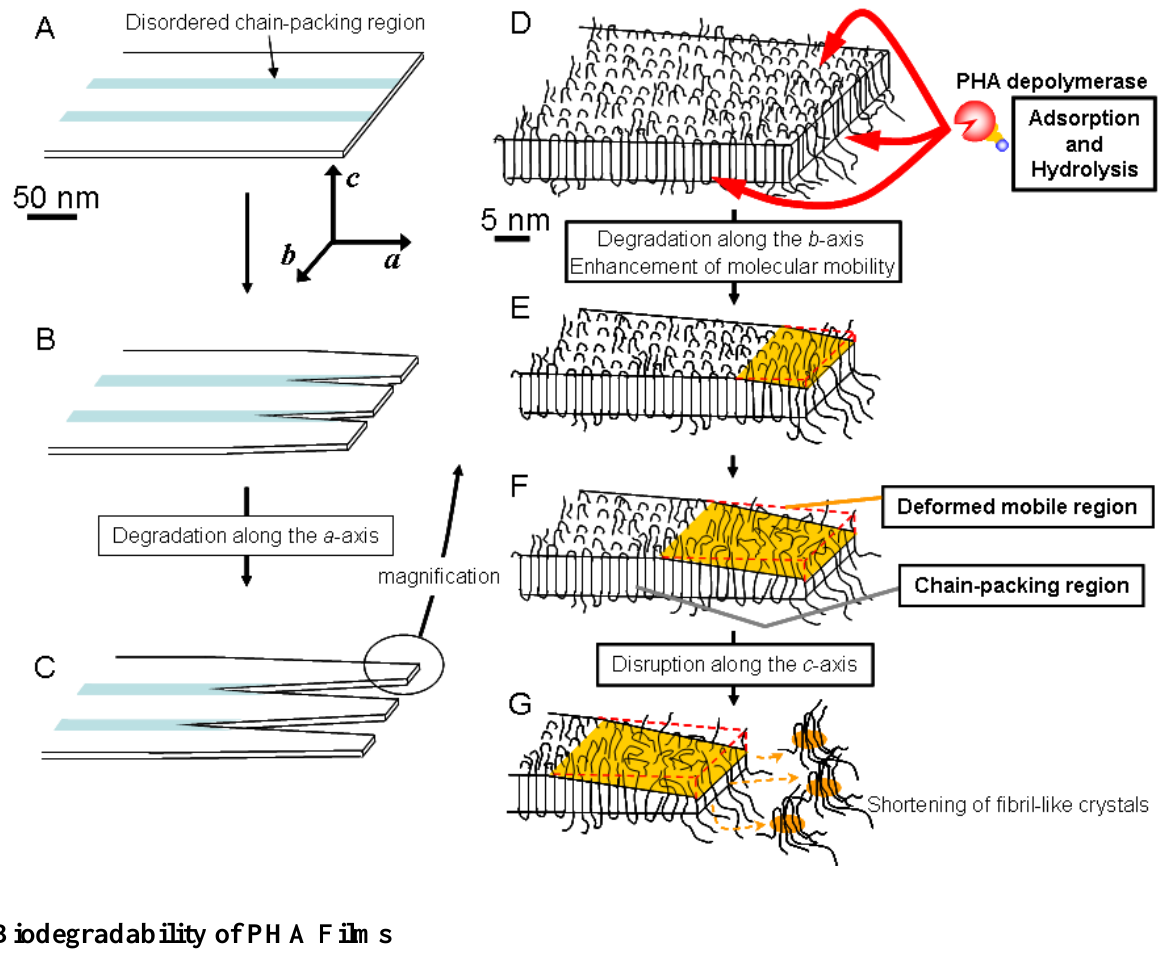
Figure 8. Schematic model of the enzymatic degradation process of PHA lamellar crystals by PHA depolymerase from R . pickettii T1 [58]. Reproduced with permission from Numata et al ., Biomacromolecules ; published by ACS,